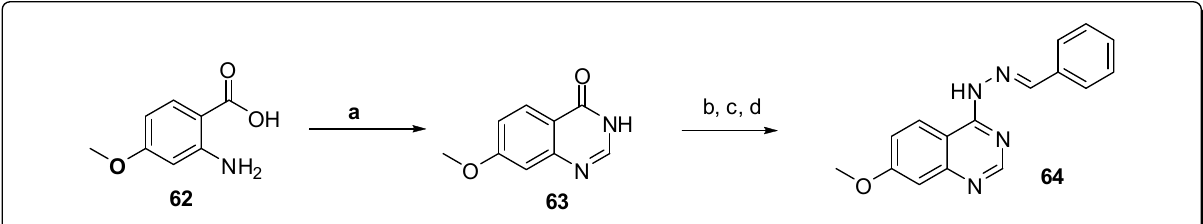
Figure 20. Use of MAOS to construct quinazoline